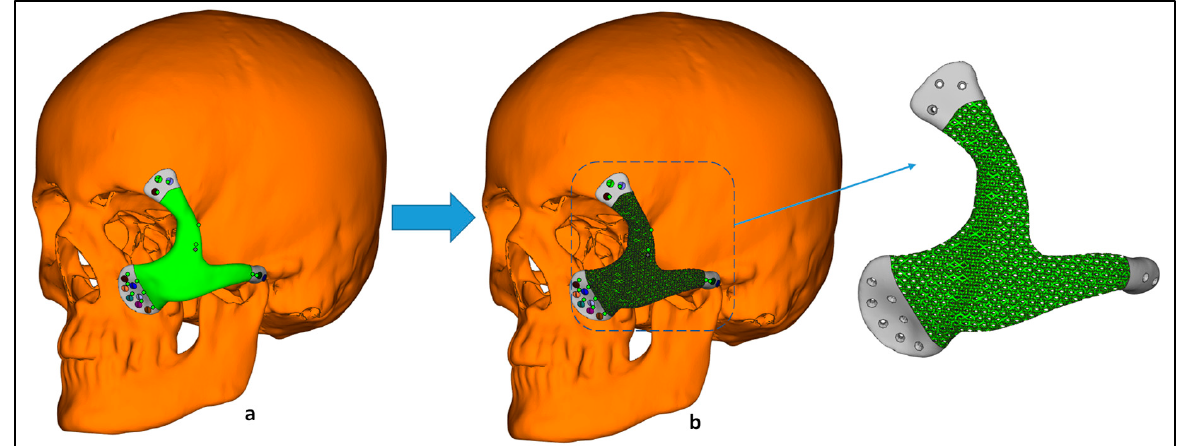
Figure 5. Transformation of ( a ) bulk craniofacial implant into a ( b ) scaffold to promote cell interaction.